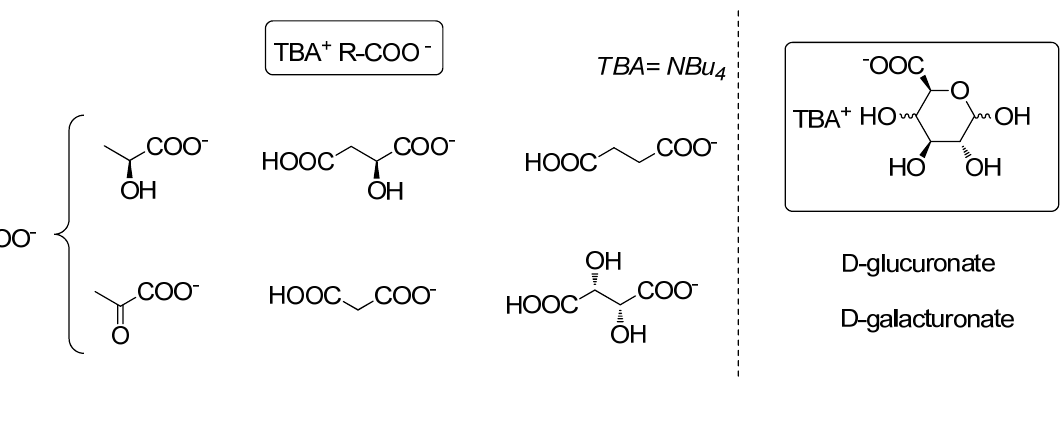
Figure 3. Biomass derived